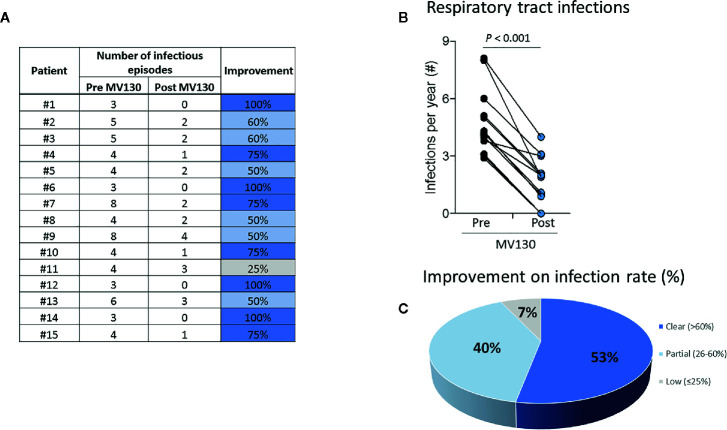
Prophylaxis with MV130 reduces the incidence of respiratory infection rate (%) in patients with B cell hematological malignancies. (A, B) Number of respiratory tract infections one year before immunotherapy with MV130 (Pre) and in the 12 months after initiation of immunotherapy (Post) (A-tabulated, B-graph). (A, C) Percentage of improvement (reduction of infections) (A-tabulated, C-pie chart). Improvement was classified as: clear (>60% reduction of infectious episodes), partial (26-60% reduction of infectious episodes) and low (<25% reduction of infectious episodes). A total of 15 patients were included. Normal distribution was evaluated using Shapiro-Wilk test, and P value was calculated comparing infectious episodes pre and post immunotherapy with MV130 using Wilcoxon signed rank test.